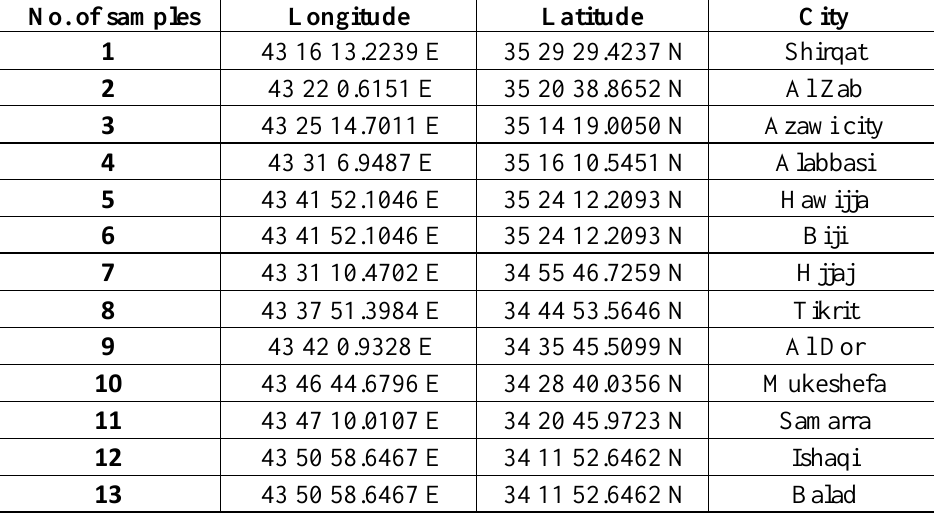
Table 1: Coordinates of water samples taken from the